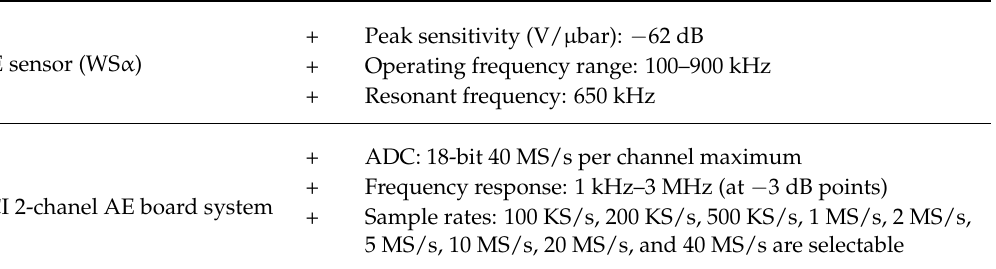
Table 2. The magnitudes of characteristic defect frequencies at various speeds.